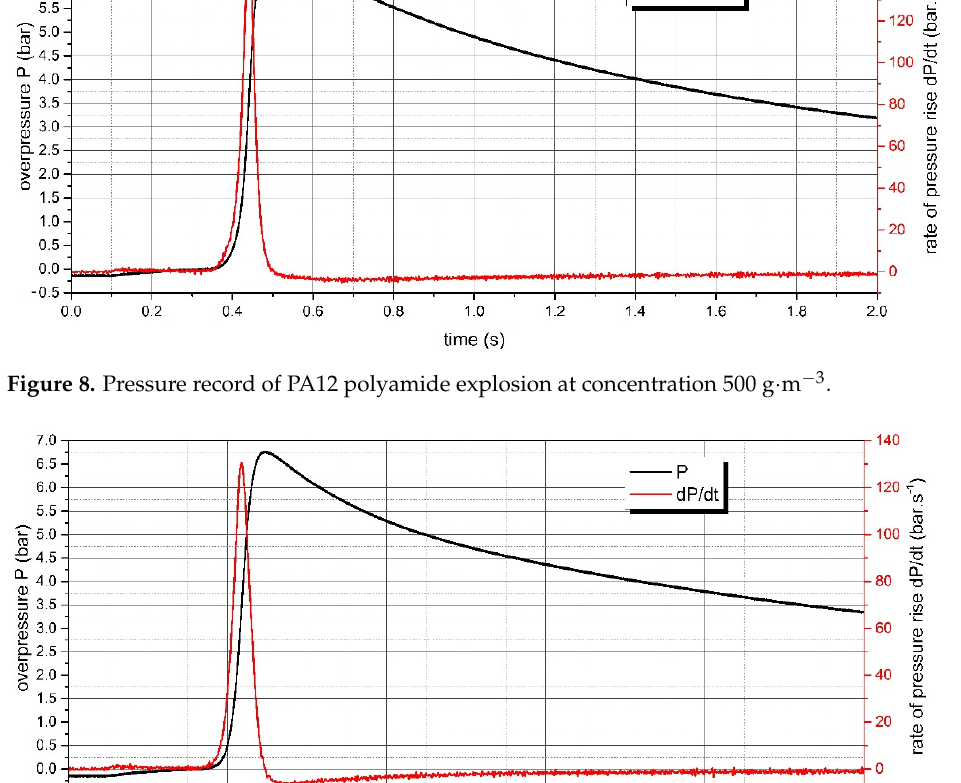
Figure 10. Pressure records for the LEL determination of PA12 polyamide sample. Table 3. Explosion parameters of PA12 polyamide sample. Concentration [g·m − 3 ]